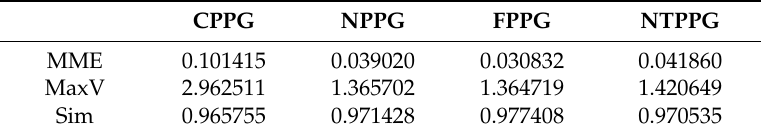
Table 3. The similarity results for the position graphs.